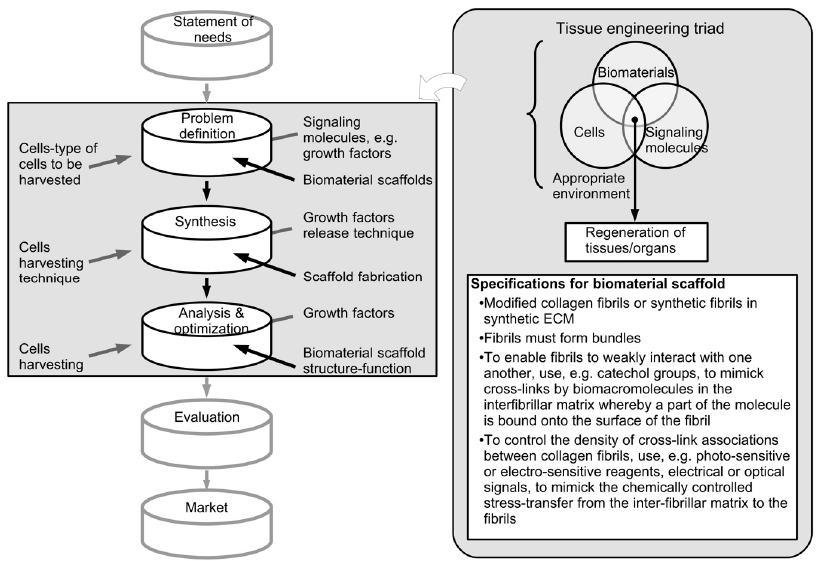
Figure 2. The design process for a tissue engineering approach. Left panel shows a flow-chart of the design process. The focus in this process is on the biomaterial for the scaffold development (highlighted in dark fonts). The flow of the design process is typical of engineering design, with the following key stages, statement of needs, problem definition, synthesis, analysis and optimization, evaluation and, finally, market [87]. Of note, some of the stages are expected to be iterative. Right panel shows the tissue engineering triad, comprising biomaterials, cells and signaling molecules. The engineering triad is linked to the problem definition stage and continues through to the analysis and optimization